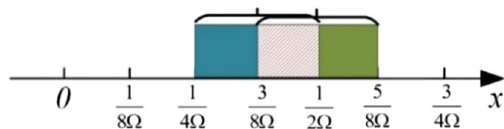
Fig. 4 Derivation schematic diagram of the spatial sampling